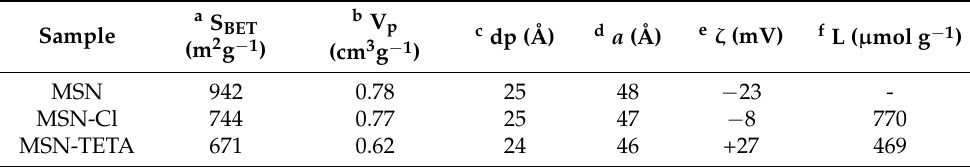
Table 1. Surface area (S BET ), pore volume (V p ), lattice spacing ( a ), zeta potential ( ζ ) and